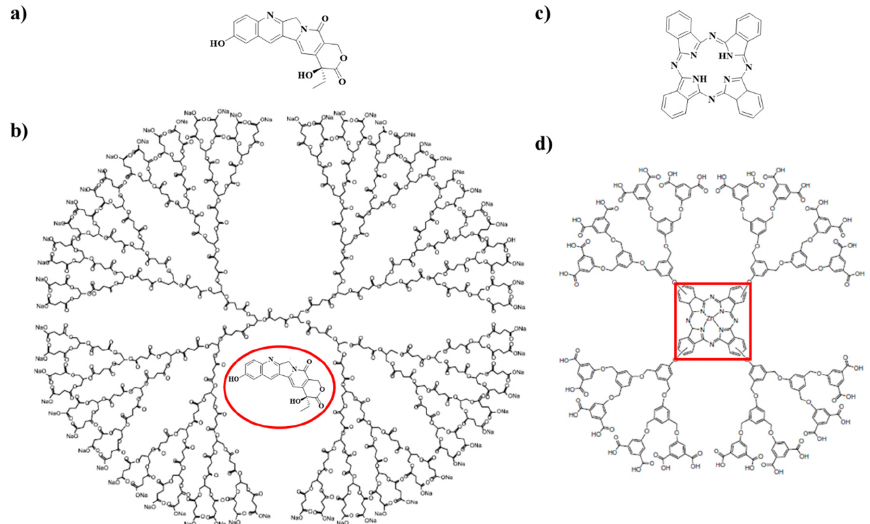
Figure 6. ( a ) Chemical structure of 10-hydroxycamptothecin (10HCPT), ( b ) Chemical structure of a poly(glycerol-succinic acid) (PGLSA)-COONa dendrimer with encapsulated 10HCPT, ( c ) phthalocyanin, a photosensitizer for non-invasive cancer treatment and ( d ) zinc phthalocyanin covalently conjugated to a dendrimer structure. Not drawn to scale.